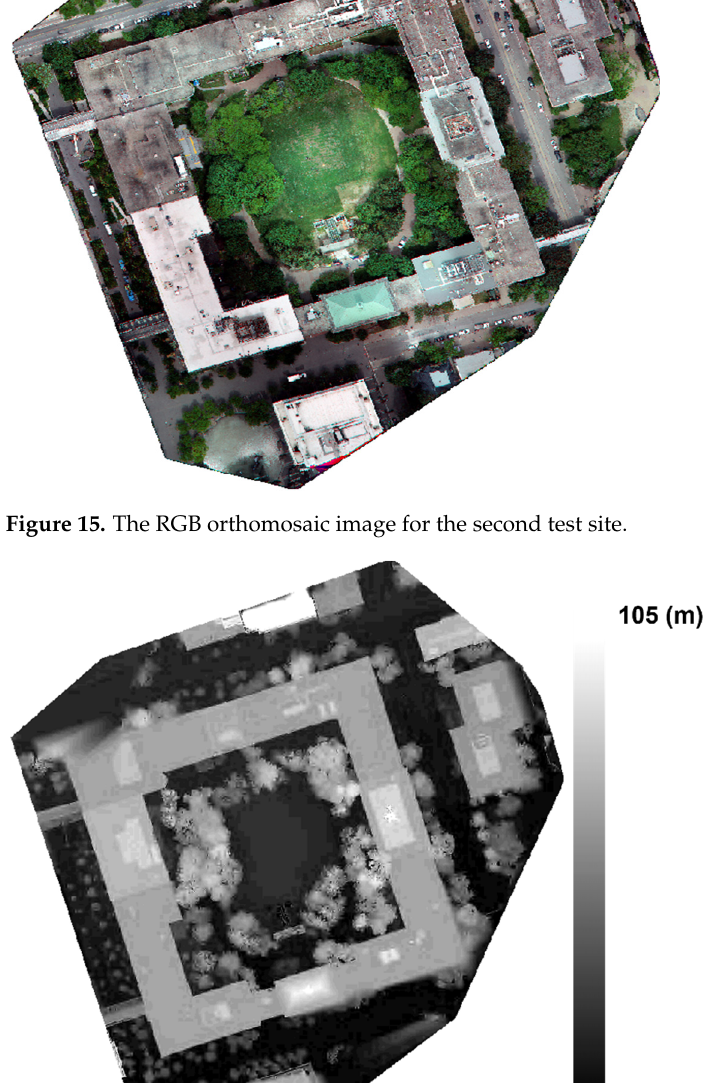
Figure 17. Intensity raster generated using the solid-state LiDAR data point cloud for the second test site.